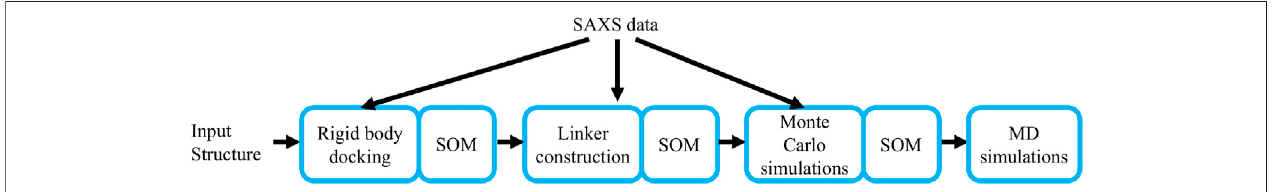
FIGURE 1 | The work fl ow of the method. The main steps of the algorithm are depicted: rigid body docking, linker construction, Monte Carlo simulations, and Molecular Dynamics (MD) simulations. The Small-angle X-ray scattering (SAXS) data is used to derive the fi rst three steps.